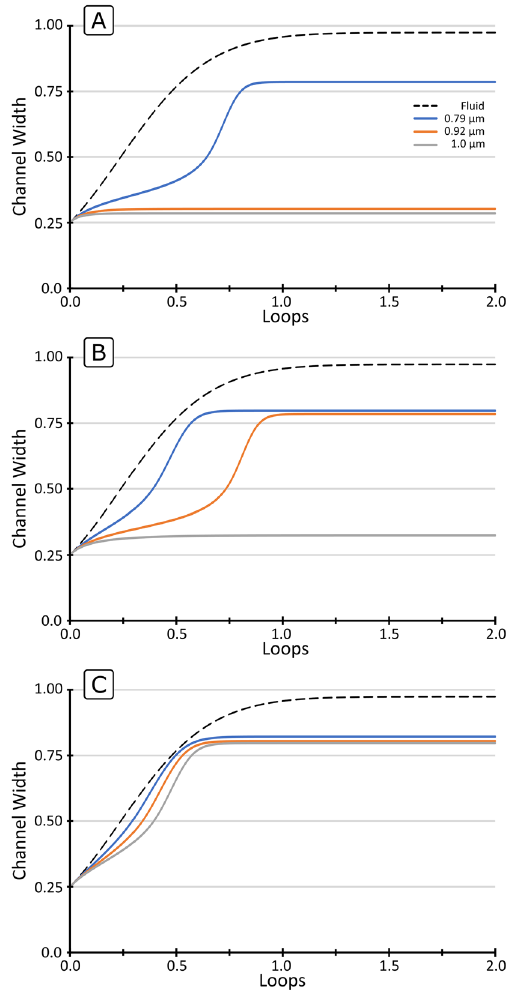
Figure 3. Trajectories of three particle sizes a (0.79, 0.92 and 1.0 µm) in sections with fixed Q (30 µL/min), W (6.15 µm) and H (14.5 µm). ( A ) R 300 µm, ( B ) R 200 µm and ( C ) R 100